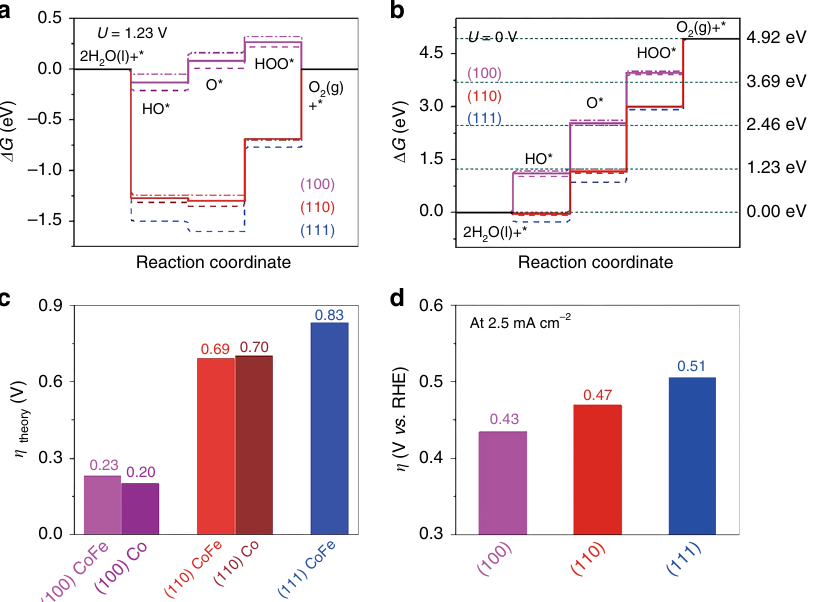
Fig. 3 DFT calculations investigating OER activities for PBSCF. a , b Gibbs free energy diagram for OER on PBSCF (100), (110), and (111) surfaces a at U = 1.23 V b and at U = 0.0 V. Dashed lines are Co-terminated surfaces, while dash-dotted are CoFe-terminated. Solid lines for (100) and (110) surfaces represent its averaged Gibbs free energies. Short dashed lines in dark cyan color are the Gibbs free energies for OER with the ideal concerted proton and electron process; c Calculated overpotentials for PBSCF with different orientation and surface termination; d Overpotentials extracted from LSV curves at a current density of 2.5 mA cm − 2